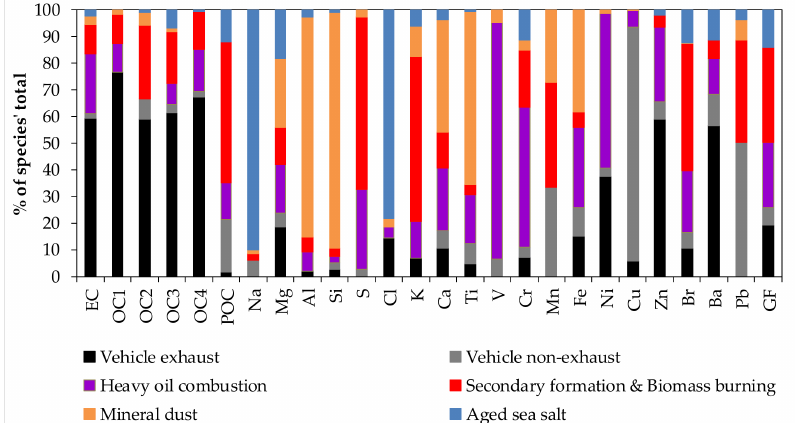
Figure 3. Relative amount of species (%) apportioned to each factor/source, obtained by applying PMF to the combined chemical composition and hygroscopicity